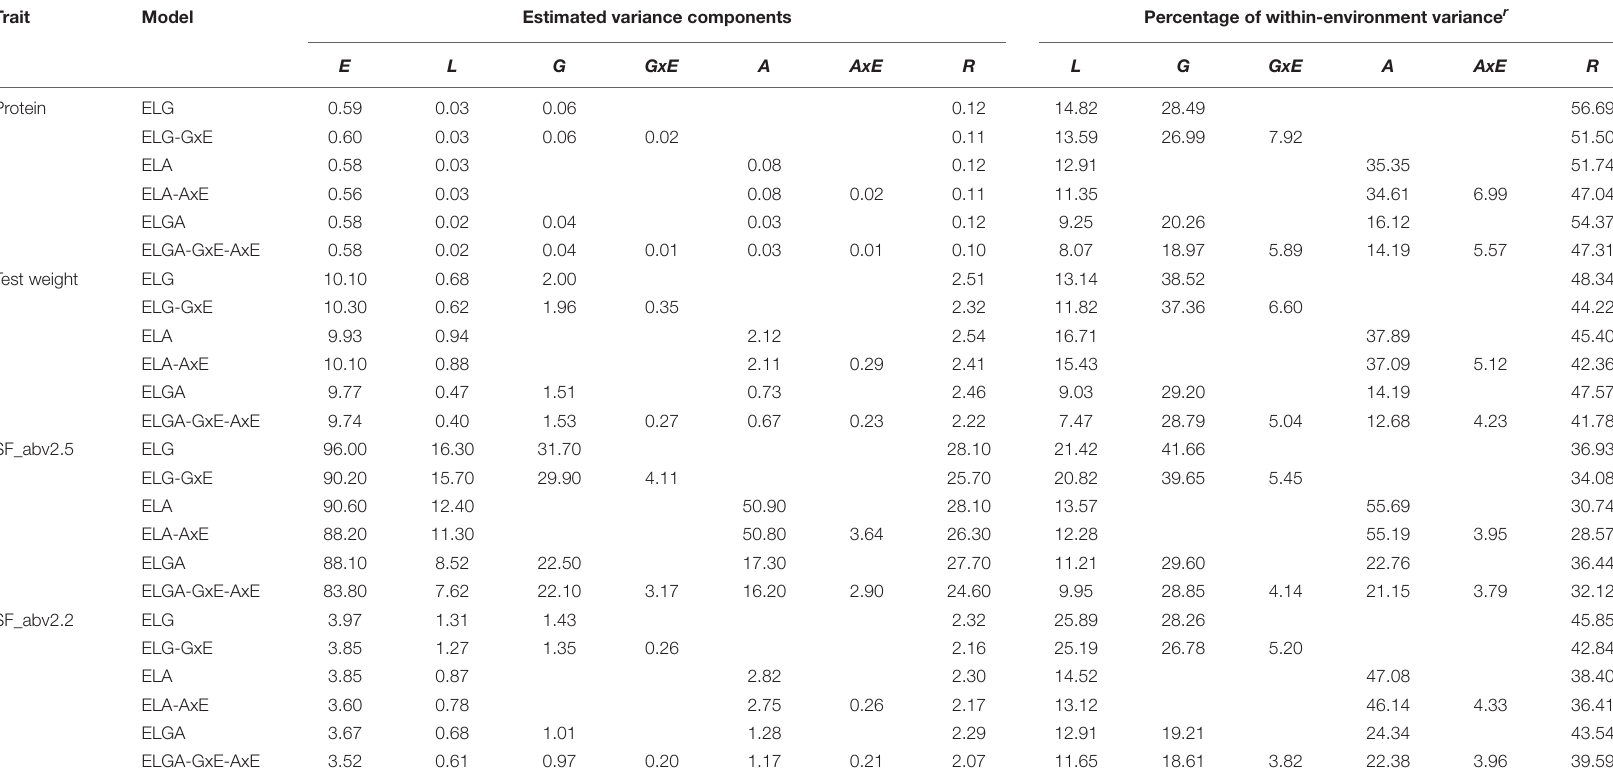
TABLE 3A | Variance components and percentage within-environment variance for random effects in the models with combined data. Trait Model